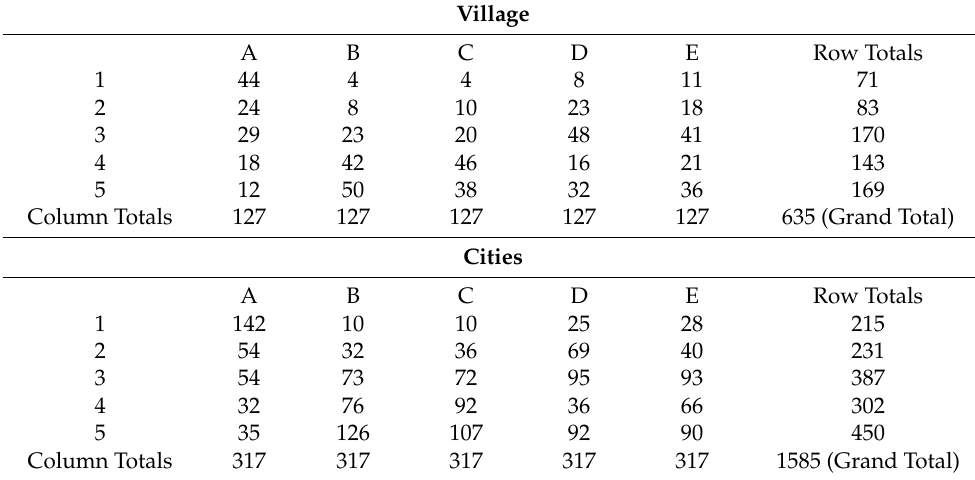
Table 5. The chi-squared test for cities and village e